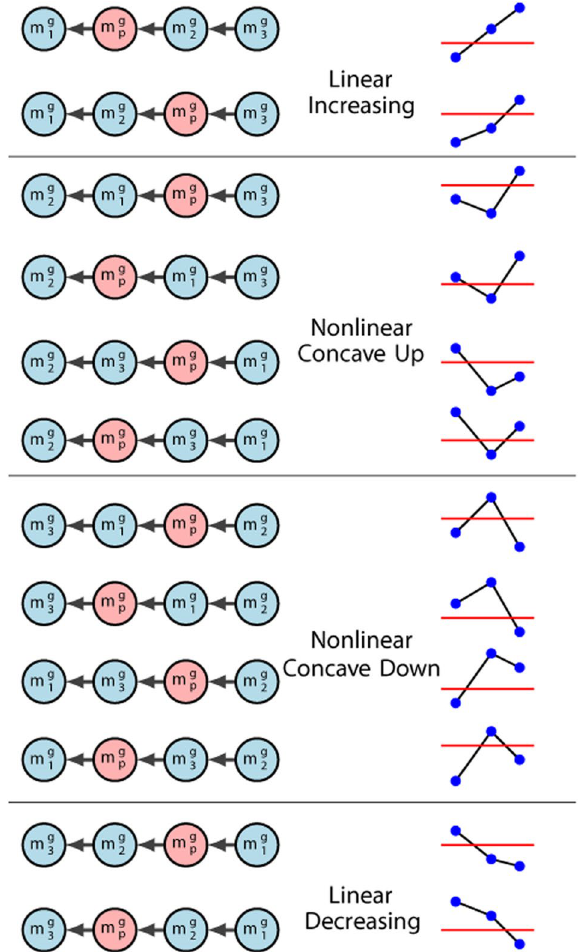
Figure 2. Gene expression profiles of the short time series of IHs and propranolol. On the left, the directed graphs (with direction given by the ≤ relation) representing all combinations considered based on the mean expression levels for a gene g on IHs samples at times 6 mo ( m g treatment m pg with respect to controls. The graphical representation of the right shows propranolol mean expression (red line) with the interpolation of IHs mean expression values (blue